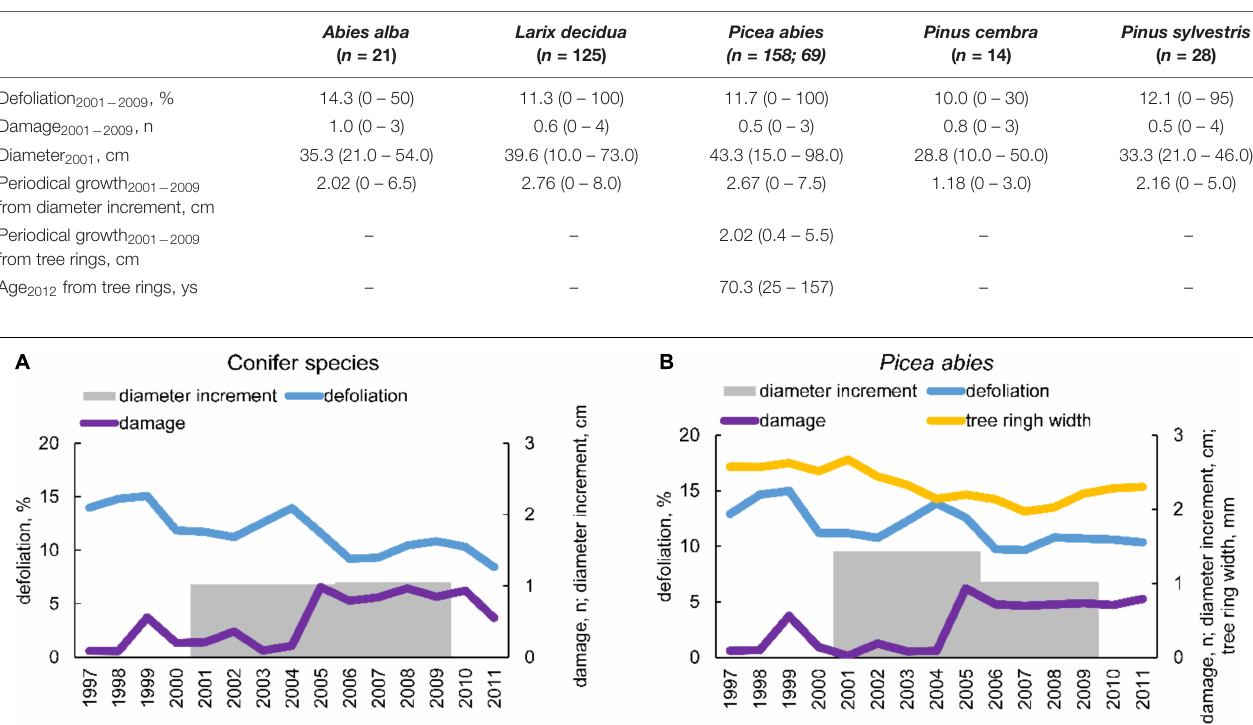
FIGURE 1 | (A) Temporal pattern of mean yearly defoliation and damage from 1997 to 2011, and periodic diameter increment between 2001 and 2005, 2005 and 2009 for the five conifer species considered; (B) temporal pattern of mean yearly defoliation and damage from 1997 to 2011 and tree ring width, and periodic diameter increment between 2001 and 2005, 2005 and 2009 for Norway spruce ( Picea abies ).